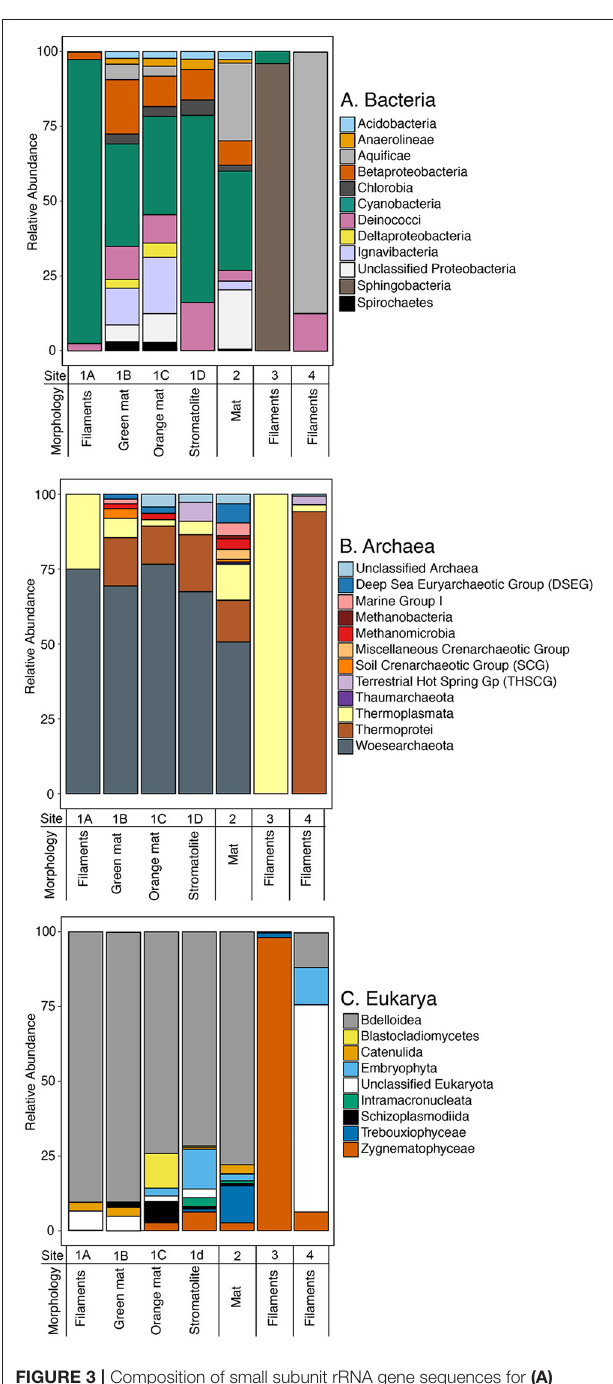
FIGURE 3 | Composition of small subunit rRNA gene sequences for (A) bacteria, (B) archaea, and (C) eukarya from microbial samples equivalent to those used for carbon uptake experiments at Sites 1, 2, 3, and 4. OTUs for each library were binned at the Class level. For eukarya and bacteria, only OTUs which were present in 50% or more of the samples are presented. Sample locations are indicated in Figure 1 .